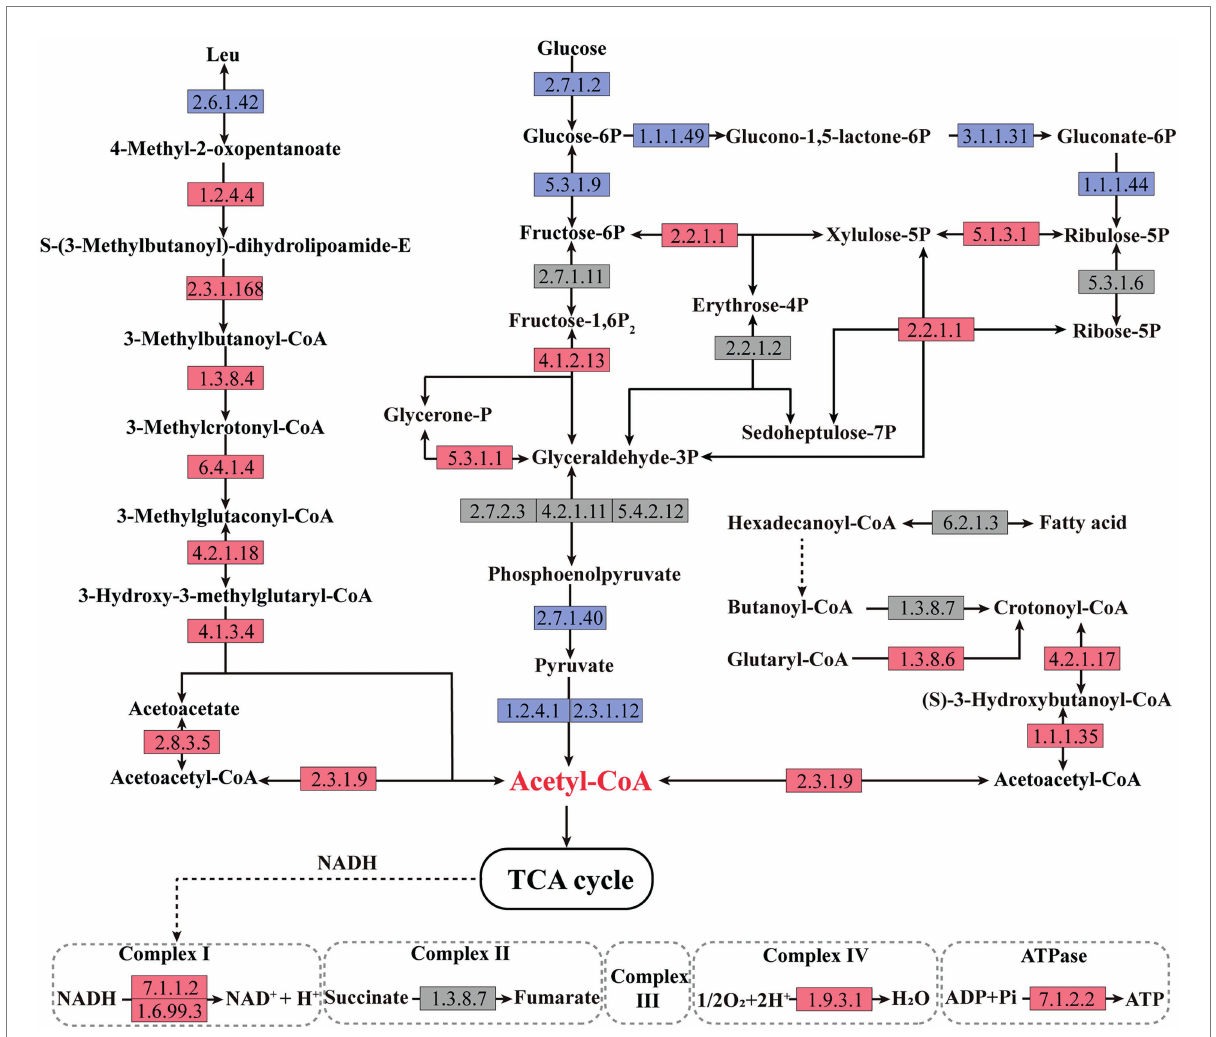
FIGURE 6 Schematic metabolic pathways of amino acid degradation, fatty acid degradation, central carbon metabolic and oxidative phosphorylation in Paracoccus denitrificans per the KEGG pathway database (https://www.genome.jp/kegg/pathway.html). The up-regulated, downregulated, and non-differentially expressed genes of the catalytic enzymes are marked with red, blue, and gray colors, respectively. The detailed different expression values could be found in Supplementary Table S1.